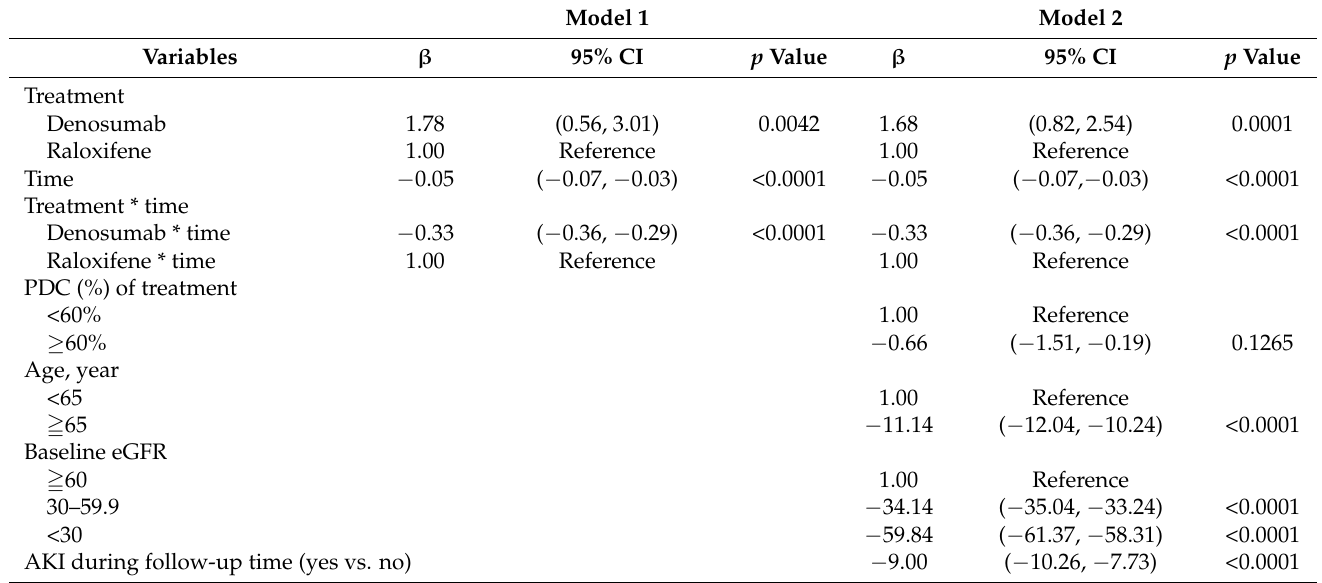
Table 3. Factors associated with mean change in eGFR over